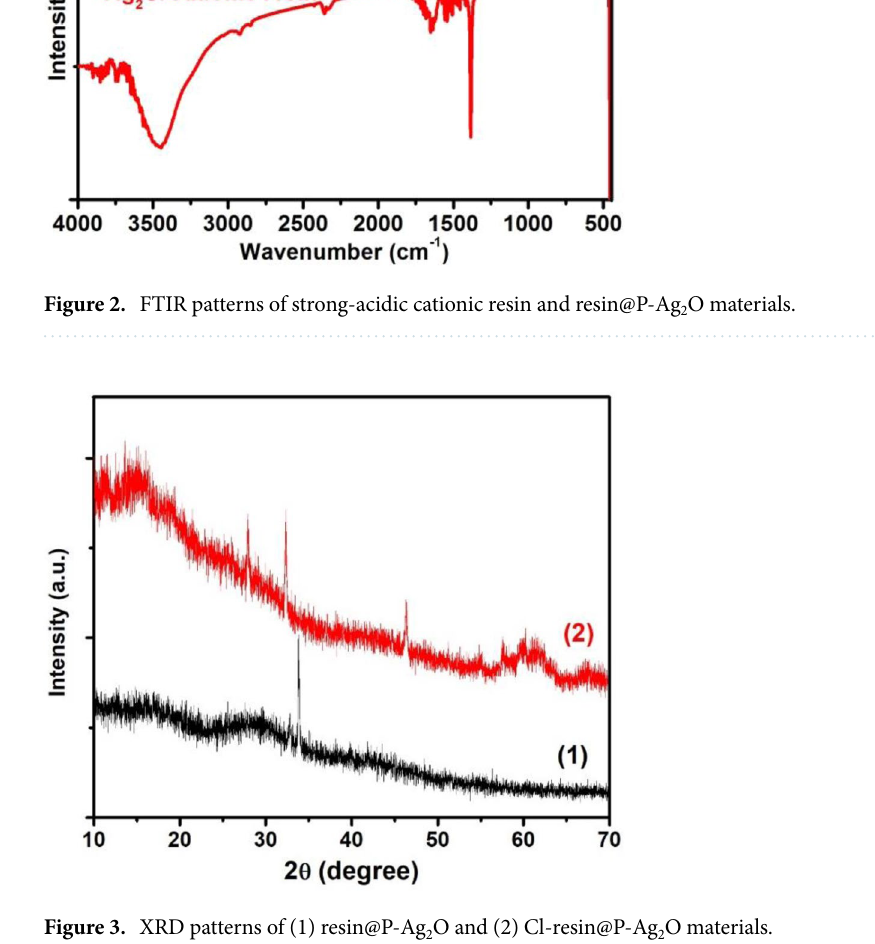
Figure 3. XRD patterns of (1) resin@P-Ag 2 O and (2) Cl-resin@P-Ag 2 O